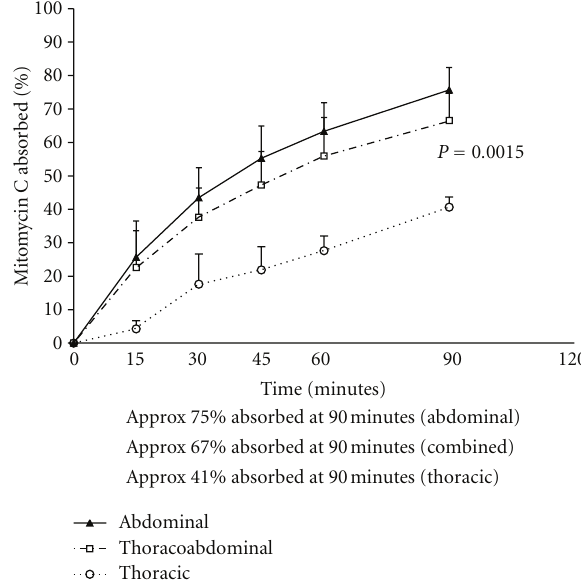
Figure 3: Comparison of percent mitomycin C absorbed after 90 minutes of treatment from the abdominal cavity, combined thoracic and abdominal cavity, and the thoracic cavity